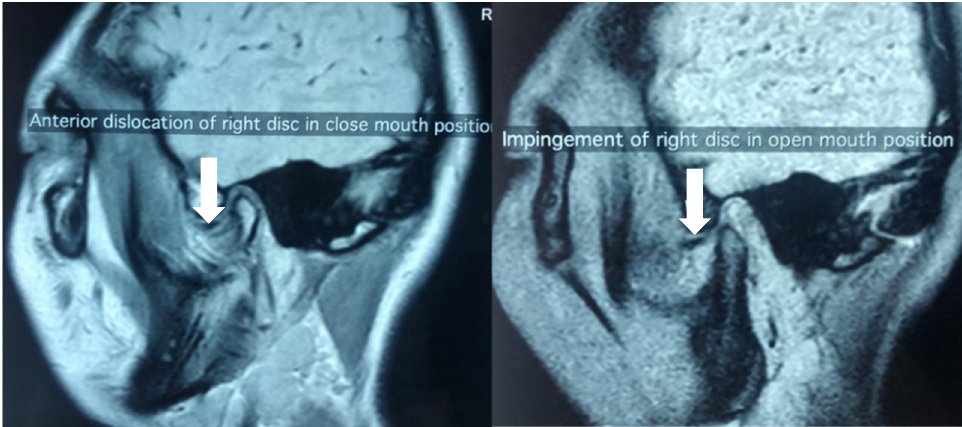
Figure 1. Magnetic resonance imaging (MRI) showing anteriorly displaced disc in both the close and open mouth position in a patient presented with lock jaw.